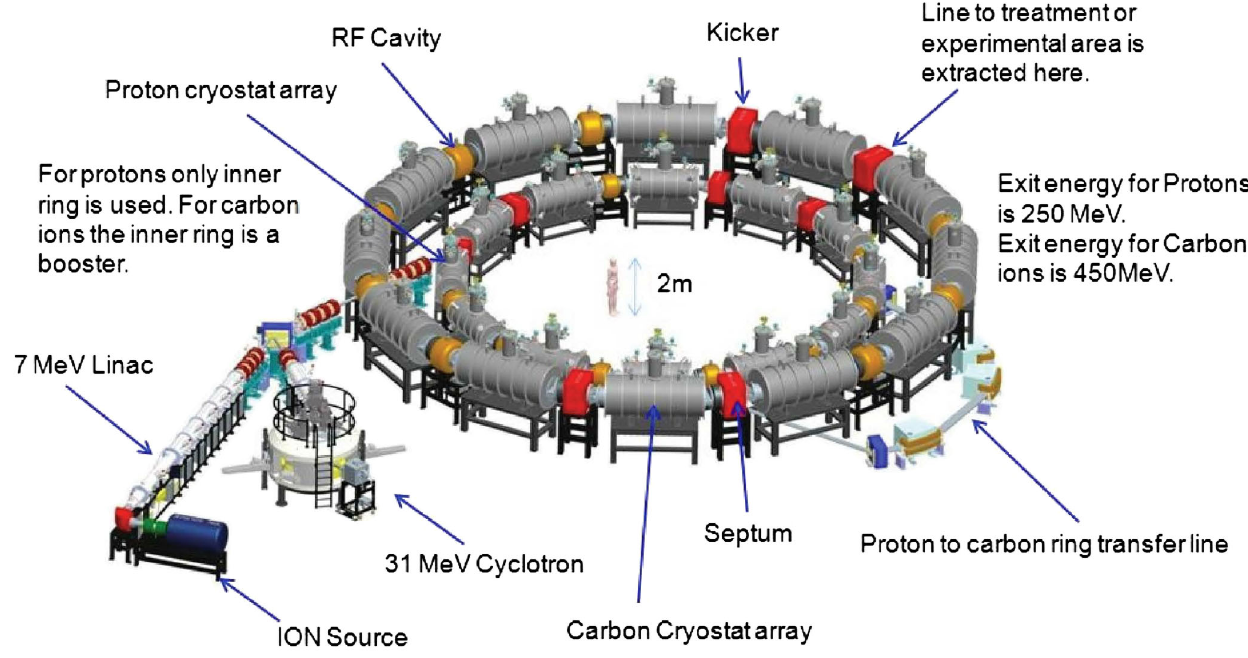
FIG. 1. Proposed PAMELA